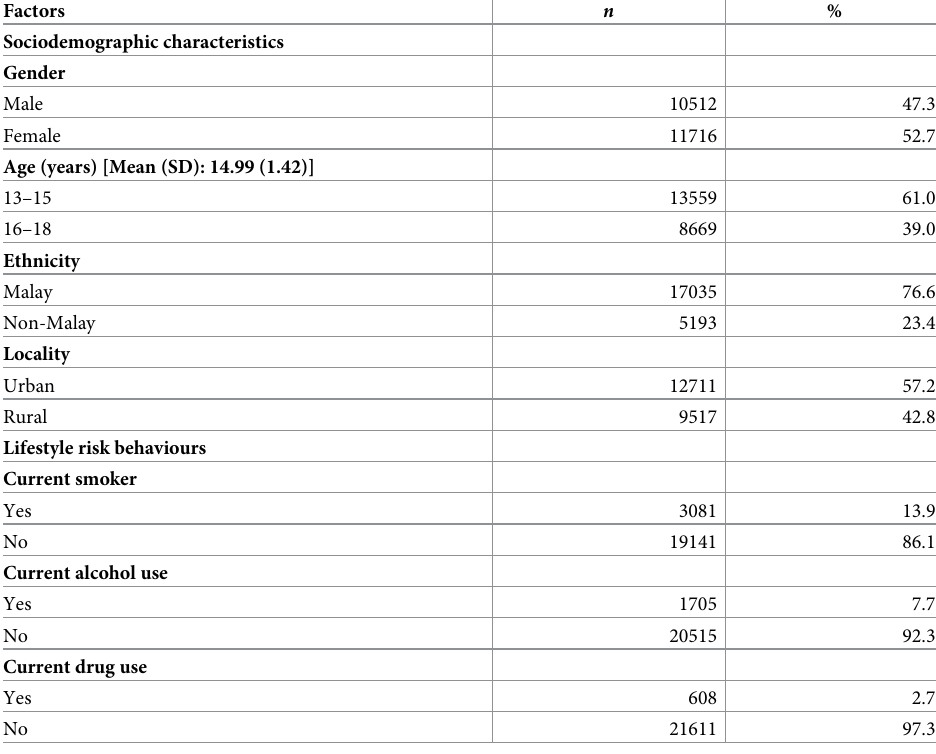
Table 1. Sociodemographic characteristics and lifestyle risk behaviours among in-school adolescents in West Malaysia.